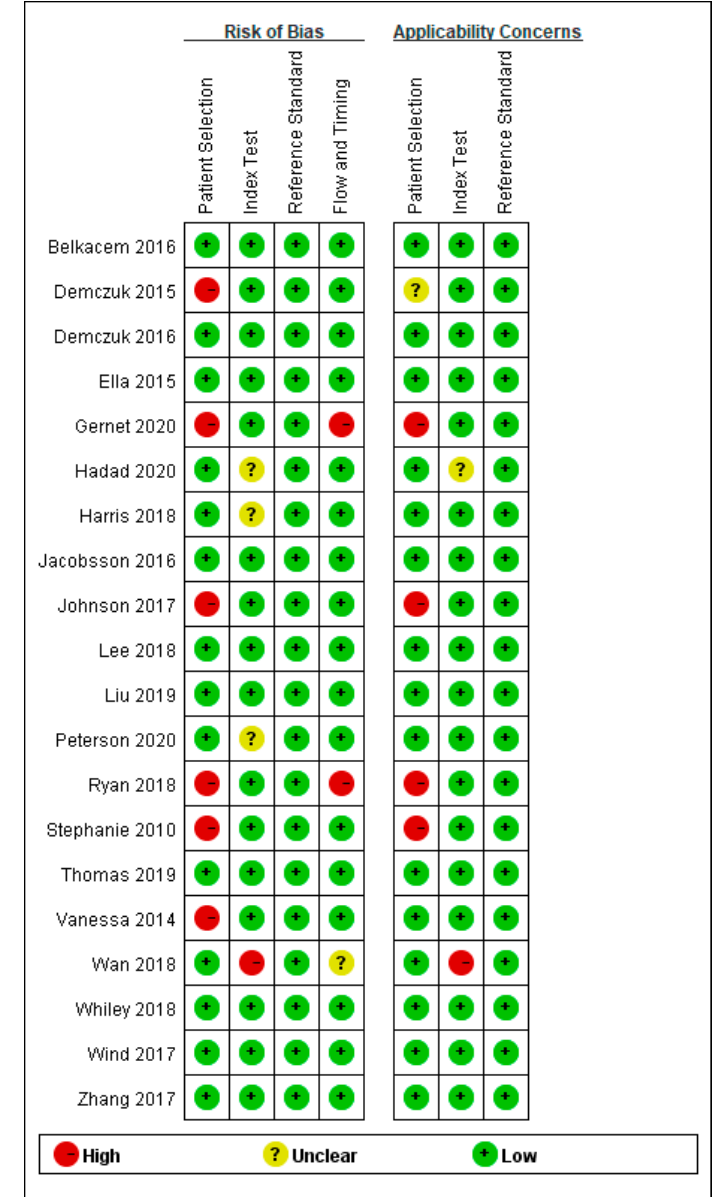
Figure 3. Risk of bias and concerns